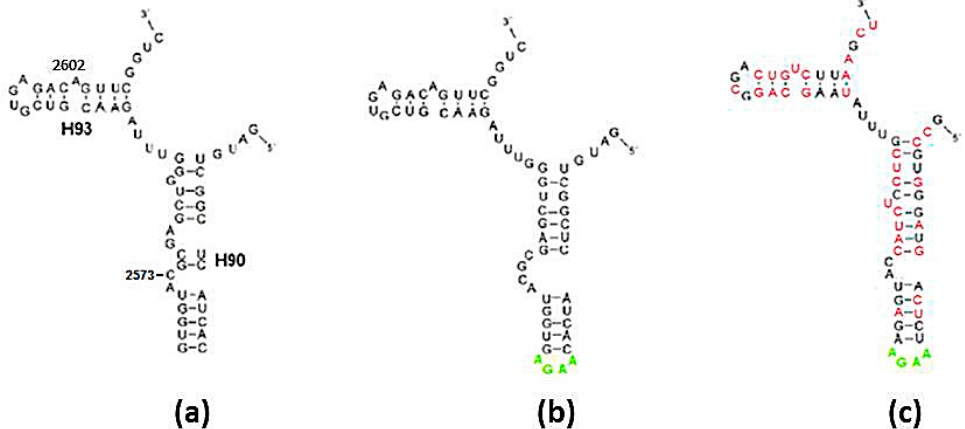
Figure 4. Folding of the A-DPR sequence: ( a ) The secondary structure found within the contemporary ribosome; ( b ) Fold prediction for the sequence in ( a ); ( c ) Fold prediction for the sequence in ( a , b ), after randomly mutating over 50% of the nucleotides, subject to the constraints determined in Section 2.1.1. Nucleotides with exchanged types are drawn in red. The stem loop of H90 (in lime) in ( b , c ) were artificially added to obtain an intact